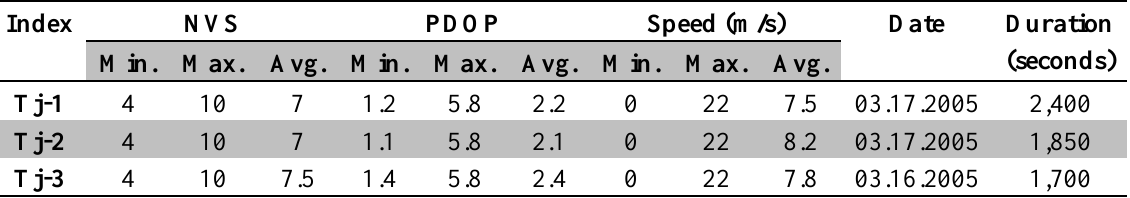
Table 2. The summary of the experimental conditions.